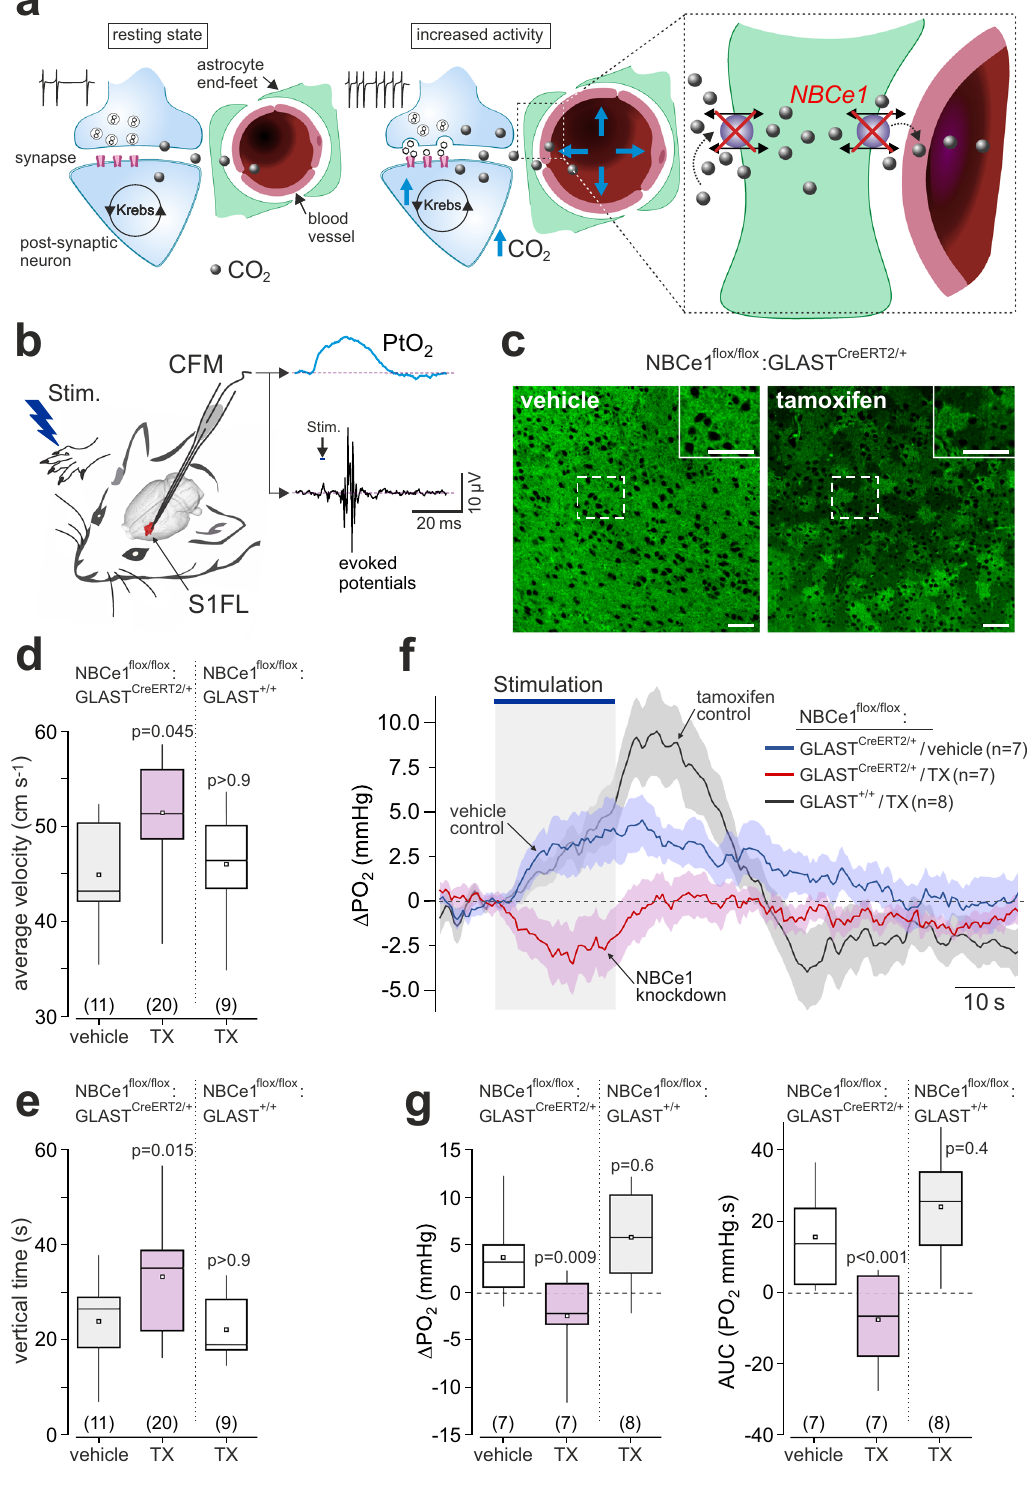
− 2.4 ± 1.7 mmHg; n = 7), resulting in a marked difference in the integral PO 2 response between the experimental and two control groups ( − 7.4 ± 4.7 AUC in NBCe1-de fi cient mice, n = 7; vs. 15.8 ± 4.8 AUC in NBCe1 fl ox/ fl ox :GLAST CreERT2/ + mice treated with the vehicle, n = 7; vs. 24.3 ± 5.0 AUC in NBCe1 fl ox/ fl ox :GLAST + / + mice treated with tamoxifen, n = 8; p = 0.009 and p < 0.001, respectively) (Fig. 4f,